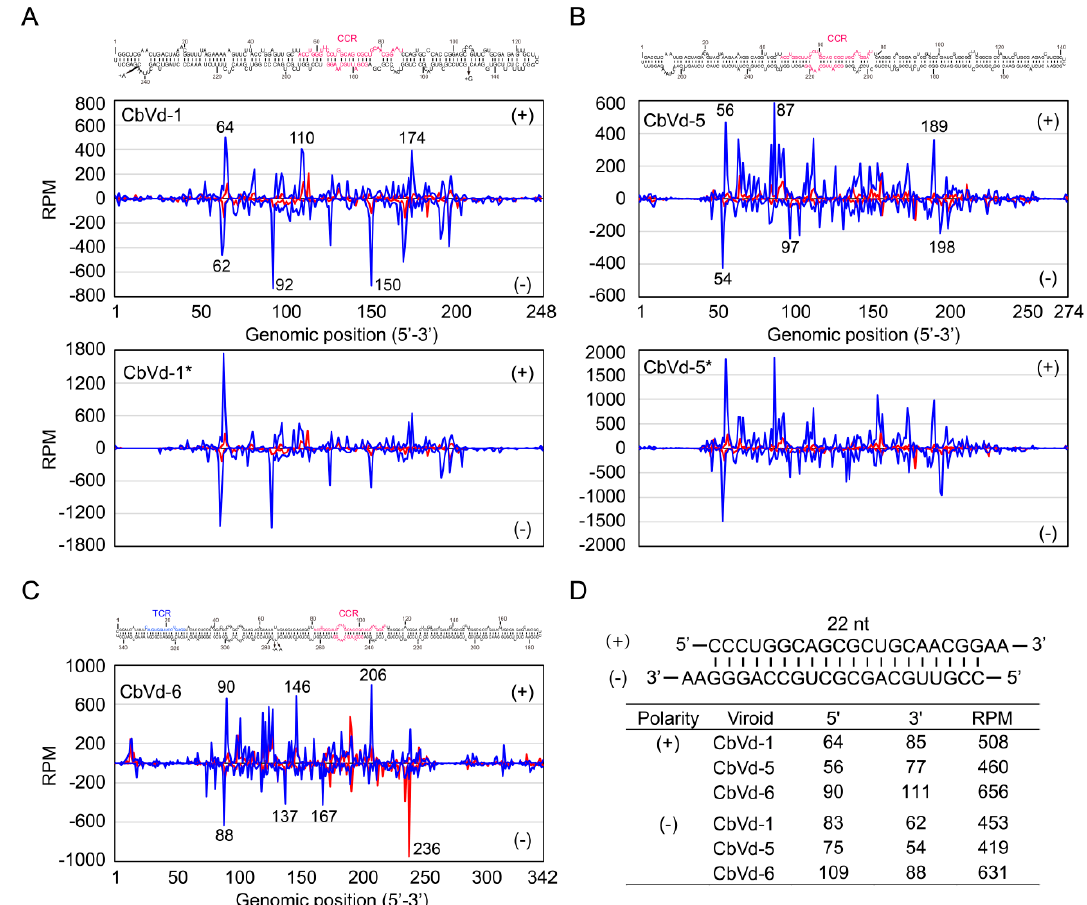
Figure 3 . Distribution of sRNAs derived from ( A ) CbVd-1, ( B ) -5, and ( C ) -6 along their genomes. sRNA of 21 nt is indicated in red and that of 22 nt in blue. The location of sRNAs indicated the position of 5’-terminal nucleotides of (+)-sRNA and that of 3’-terminal nucleotides of ( − )-sRNA. Locations of some hotspots are specifically indicated. An asterisk indicates that the viroid was from coleus plants in the field doubly infected with CbVd-1 and -5. ( D ) Sequences, location, and read numbers of two complementary vd-sRNA (22 nt) from CbVd-1, -5 and -6.